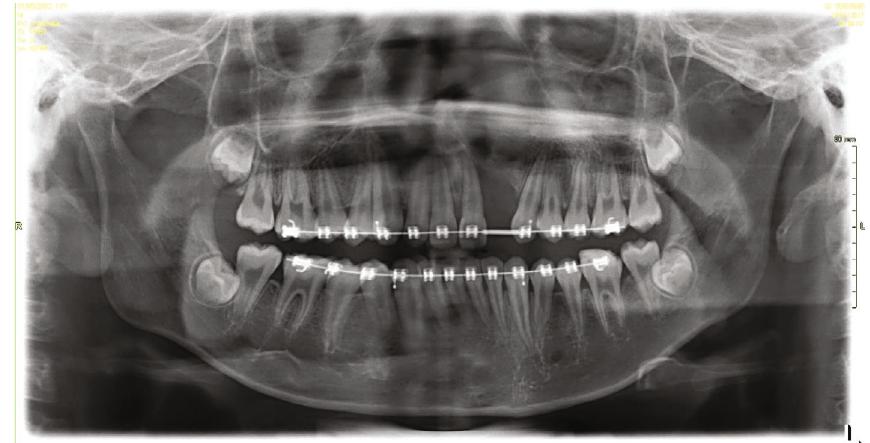
Figure 8: Panoramic radiograph after graft surgery.